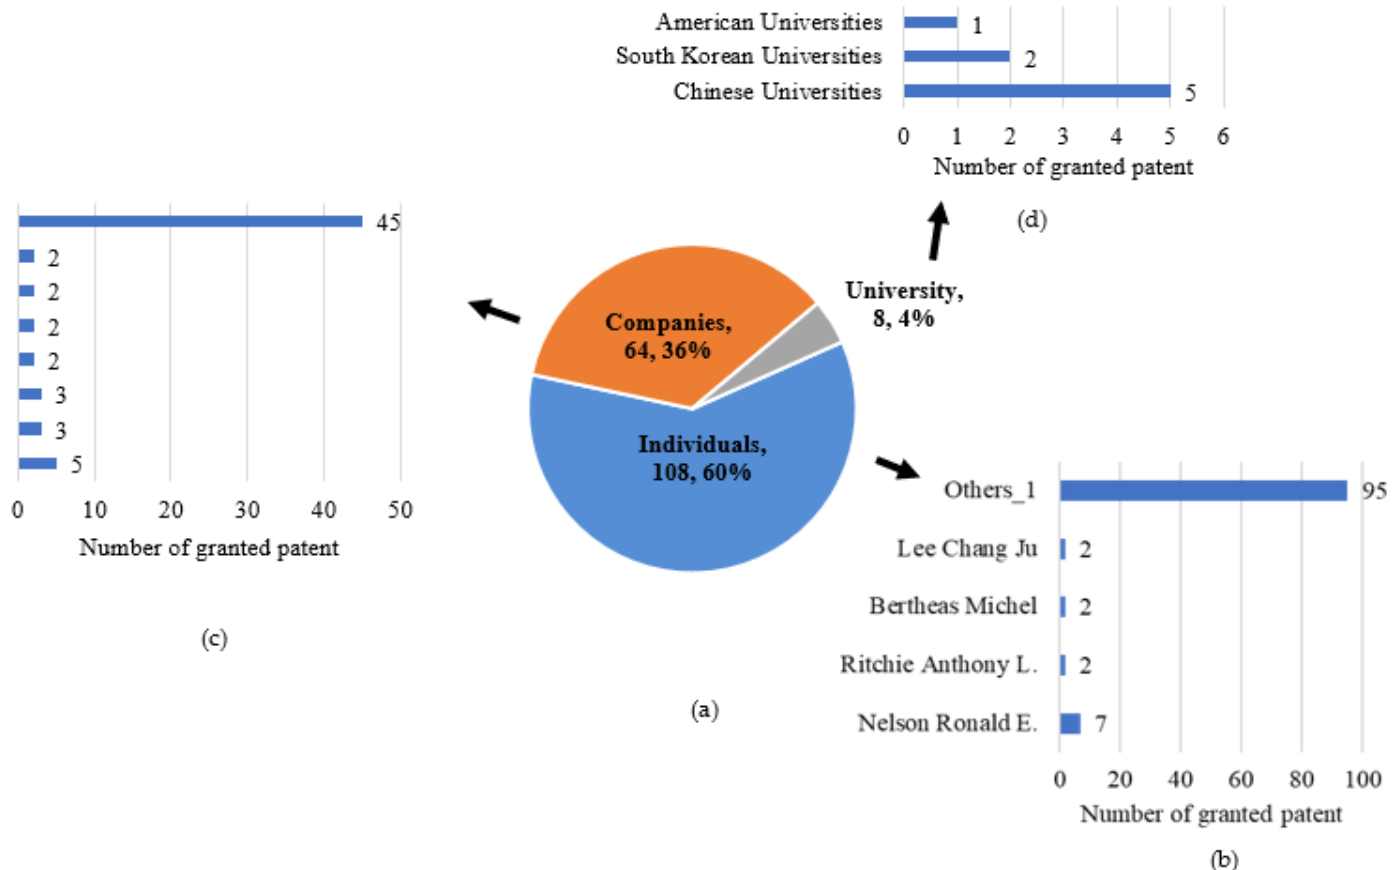
Figure 6. ( a ) Categories of applicants of granted patents, ( b ) Individual applicants of granted patents, ( c ) Company applicants of granted patents, and ( d ) Countries of university applicants of granted patents, on ankle sprain prevention methods.